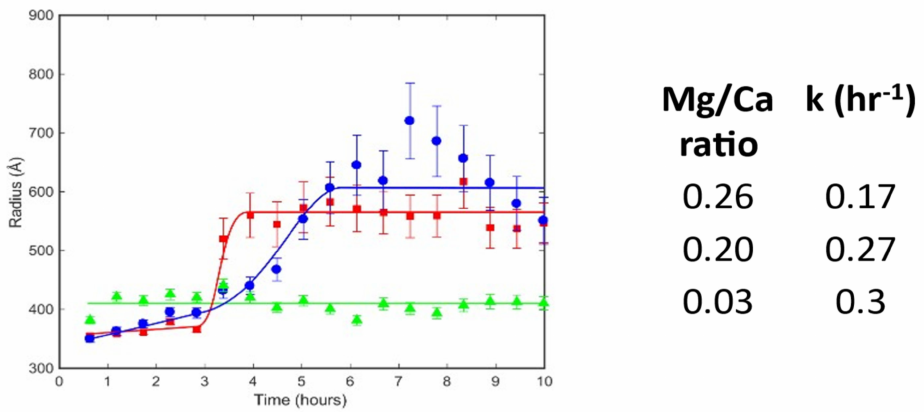
Figure 4. Evolution of the particle size in the samples analysed at 20 ◦ C (ambient) with time. is for the sample with Mg/Ca = 0.26; is for the sample with Mg/Ca = 0.20; and is for the sample with Mg/Ca = 0.03. The corresponding lines are guides for the eye. The table contains estimates of the rate of transformation between the 35 nm and nm particles for three Mg/Ca ratios.